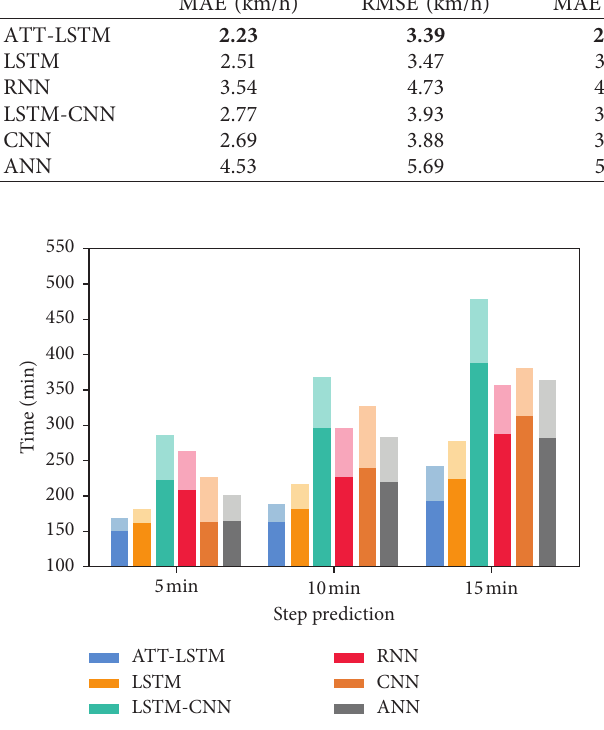
Figure 17: Average training time of various algorithms.